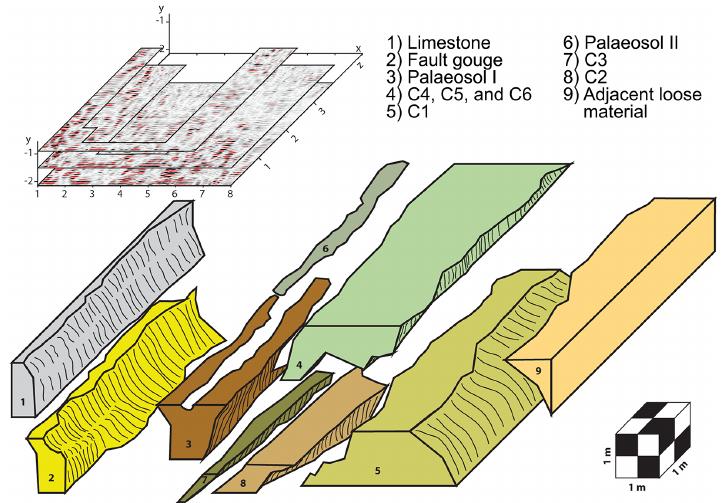
Figure 8. 3-D reconstruction of differing layers within the outcrop from GPR image interpretation. Partial reflection of radar waves on layer contacts leads to significant backscatter signals at depths down to approximately